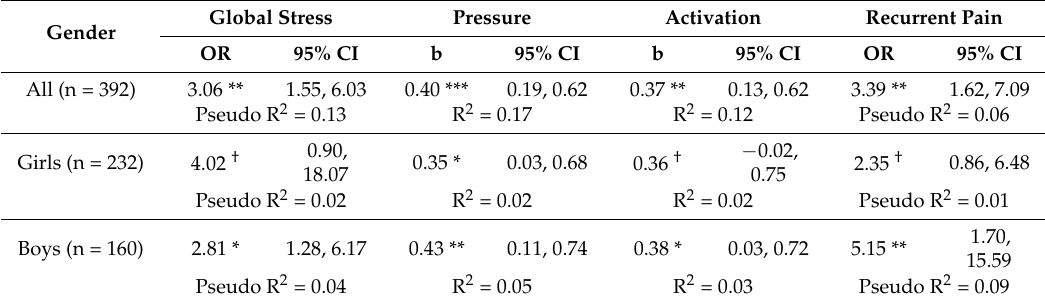
Table 2. Results from binary logistic regressions of global stress and recurrent pain, and from linear (OLS) regressions of pressure and activation, by exposure to bullying. Estimates are presented for bullied students (omitted reference category = not